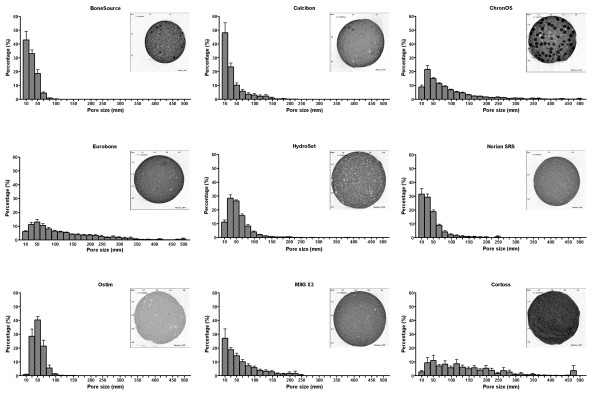
Distribution of pore sizes of bone substitutes The frequency of pore sizes varying from 10 to 500 μm are shown. Bars indicate the mean ± SD of the individual test samples (N = 9 to 12 per product). For each product, a typical example is given in the upper right corner of the panel.